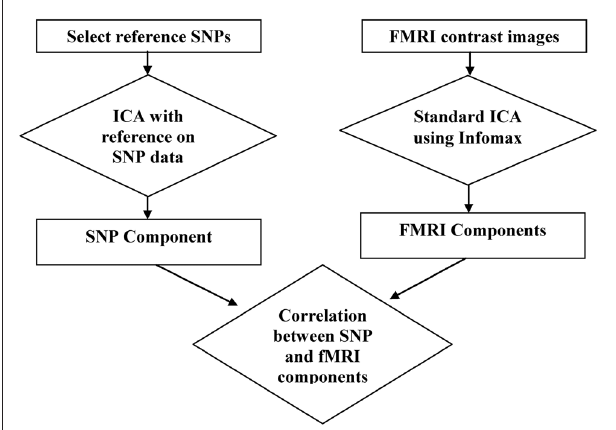
FIGURE 1 | The flowchart of the proposed